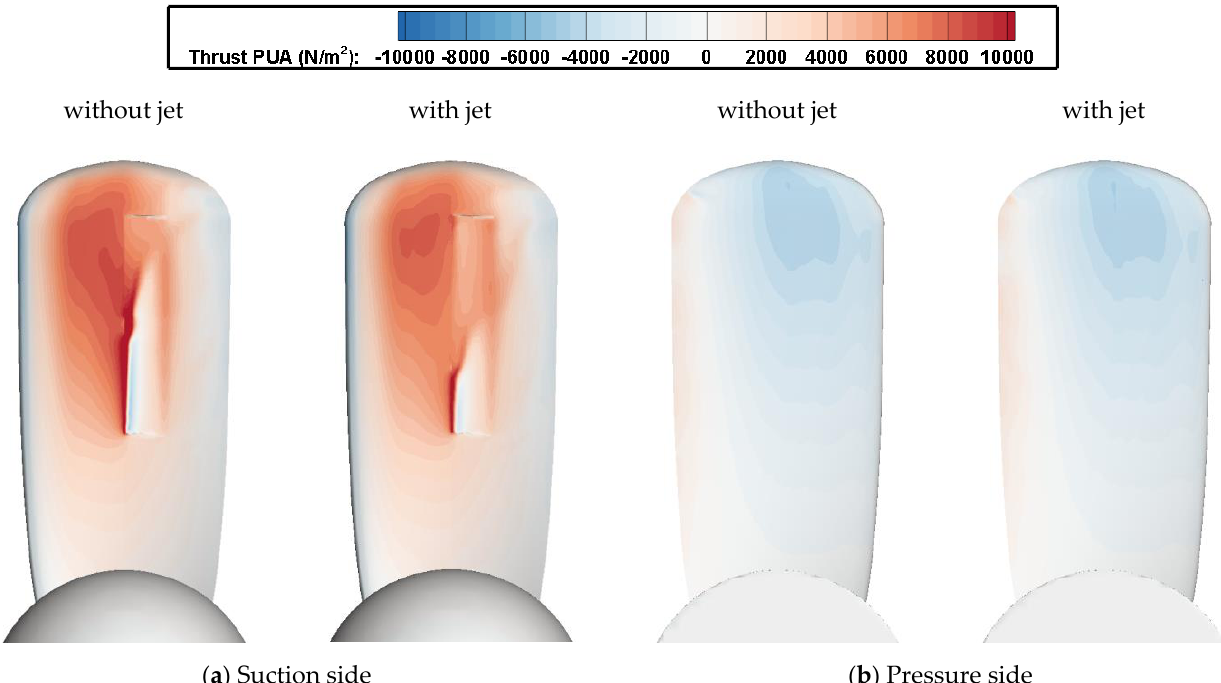
Figure 8. Thrust PUA distribution on the propeller surface with and without jet injection ( J A = 0.4).